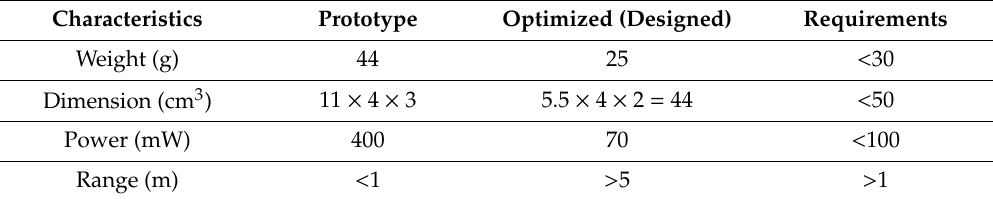
Table 2. Comparison between the prototype and the optimized modules (ultrasound).